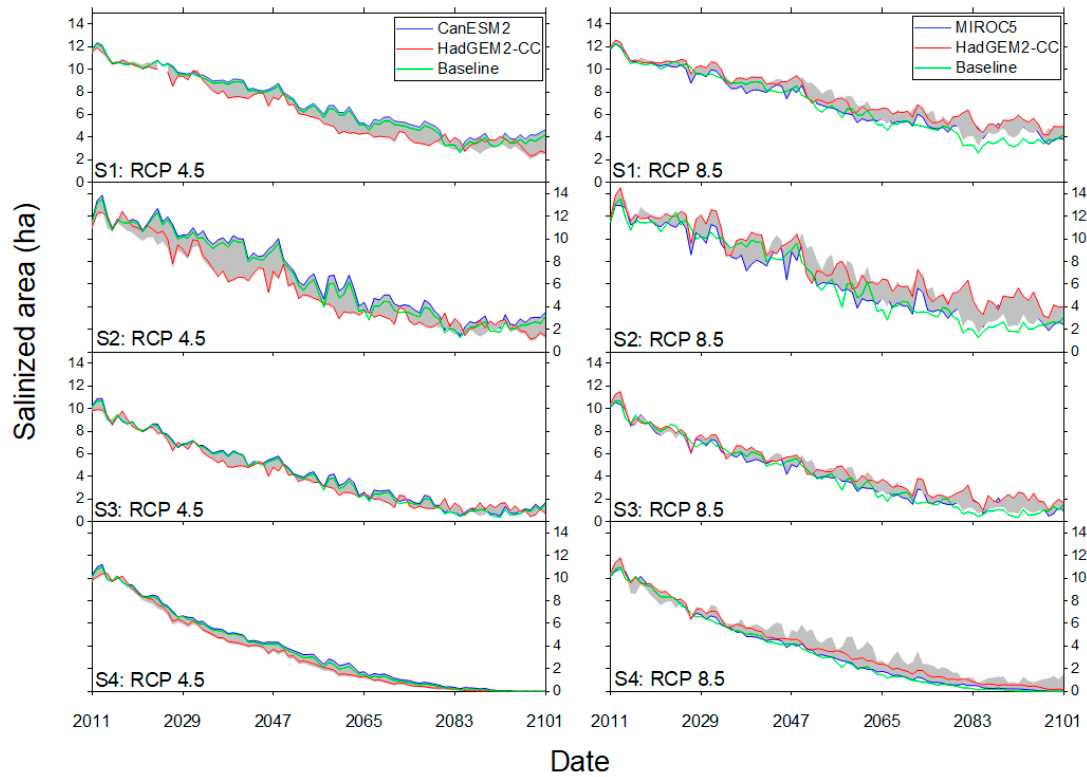
Figure 11. Total salinized area across different partial afforestation configurations and RCP scenarios.